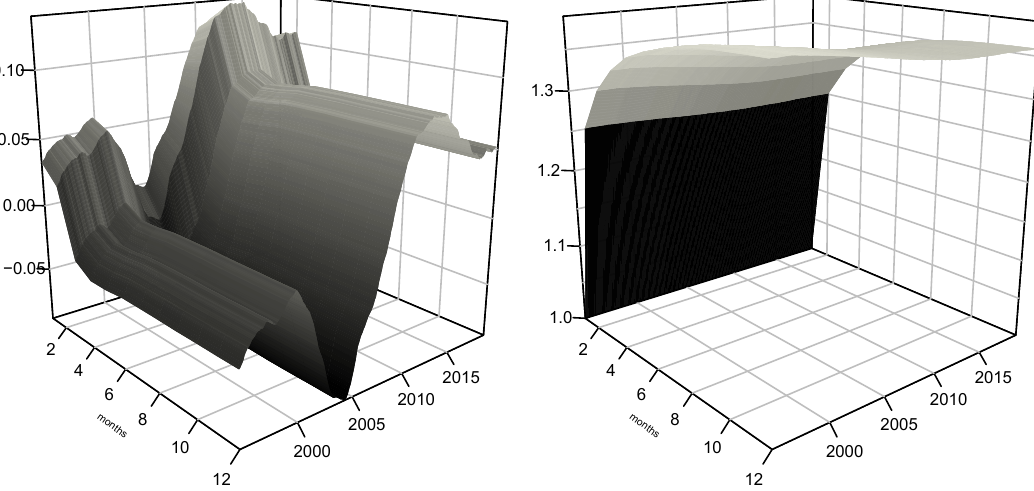
Figure A4. Three-dimensional responses of stock returns to structural shocks. Note: This figure presents the three-dimensional accumulated responses of stock returns to a one-unit shock for each structural shock (1995:04–2019:06).